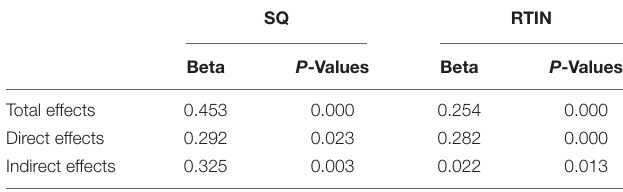
TABLE 4 | Mediation